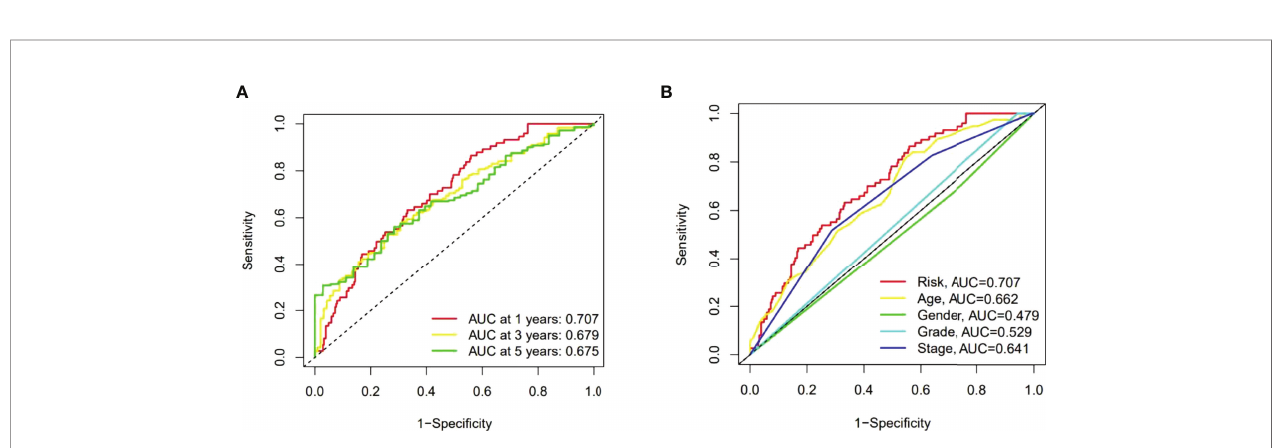
FIGURE 5 | Nomogram of the risk model. Cox analyzes of clinical characteristics and risk score with OS (Uni- and multi-Cox in A, B ). The nomogram that combined age, the risk score, and tumor stage forecasted the 1-, 3-, and 5-year OS probabilities. (C) The 1-, 3-, and 5-year OS calibration curves (D) .